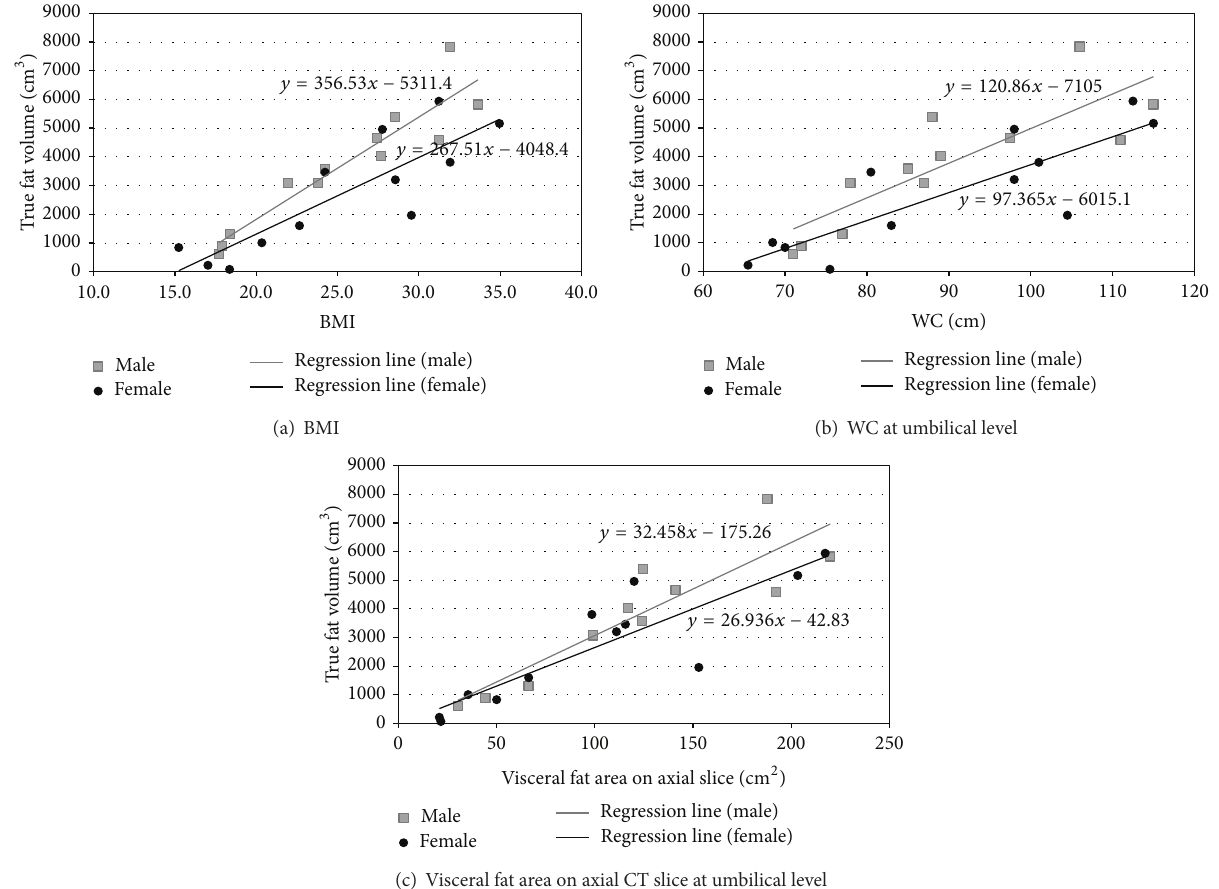
Figure 4: Linear correlations between the true visceral fat volume and the substitute indices for the visceral fat volume and their linear regression